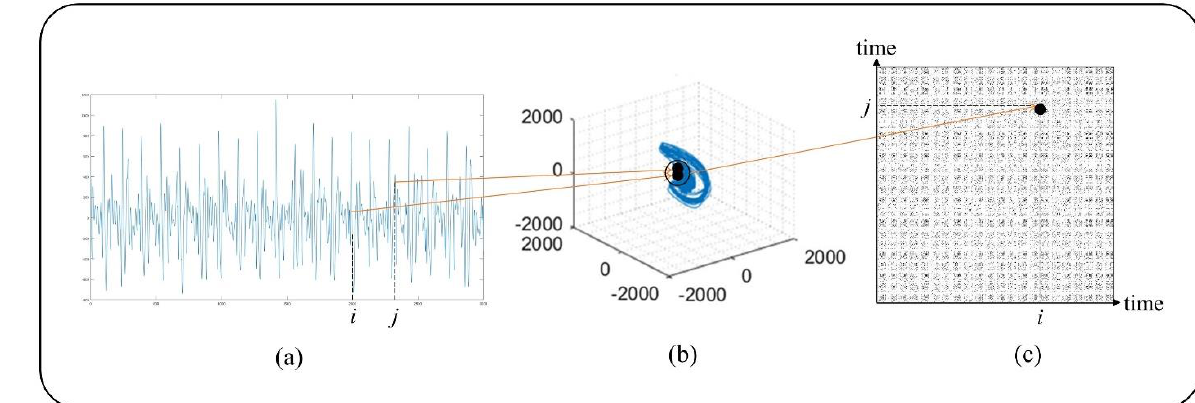
Figure 2. RP reconstruction schematic diagram: after the BCG signal is transformed into phase space trajectory, RP is obtained through RP reconstruction, where ( a ) is the waveform of the 24-s BCG segment, ( b ) is the phase space trajectory of BCG, and ( c ) is the RP of BCG. The basis of RP reconstruction is to reconstruct the phase space. Takens theorem states that a phase space can be reconstructed by the system component after selecting the appropriate delay time τ and embedding dimension m for the time series, which contains all of the information of the original time series [28].